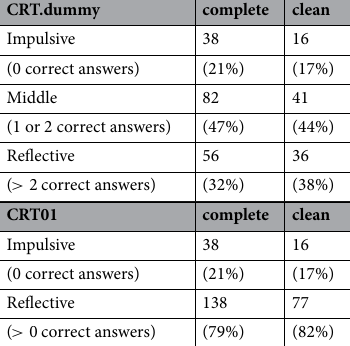
Table 5. Classifications of subjects according to the level of reflectivity in the Cognitive Reflection